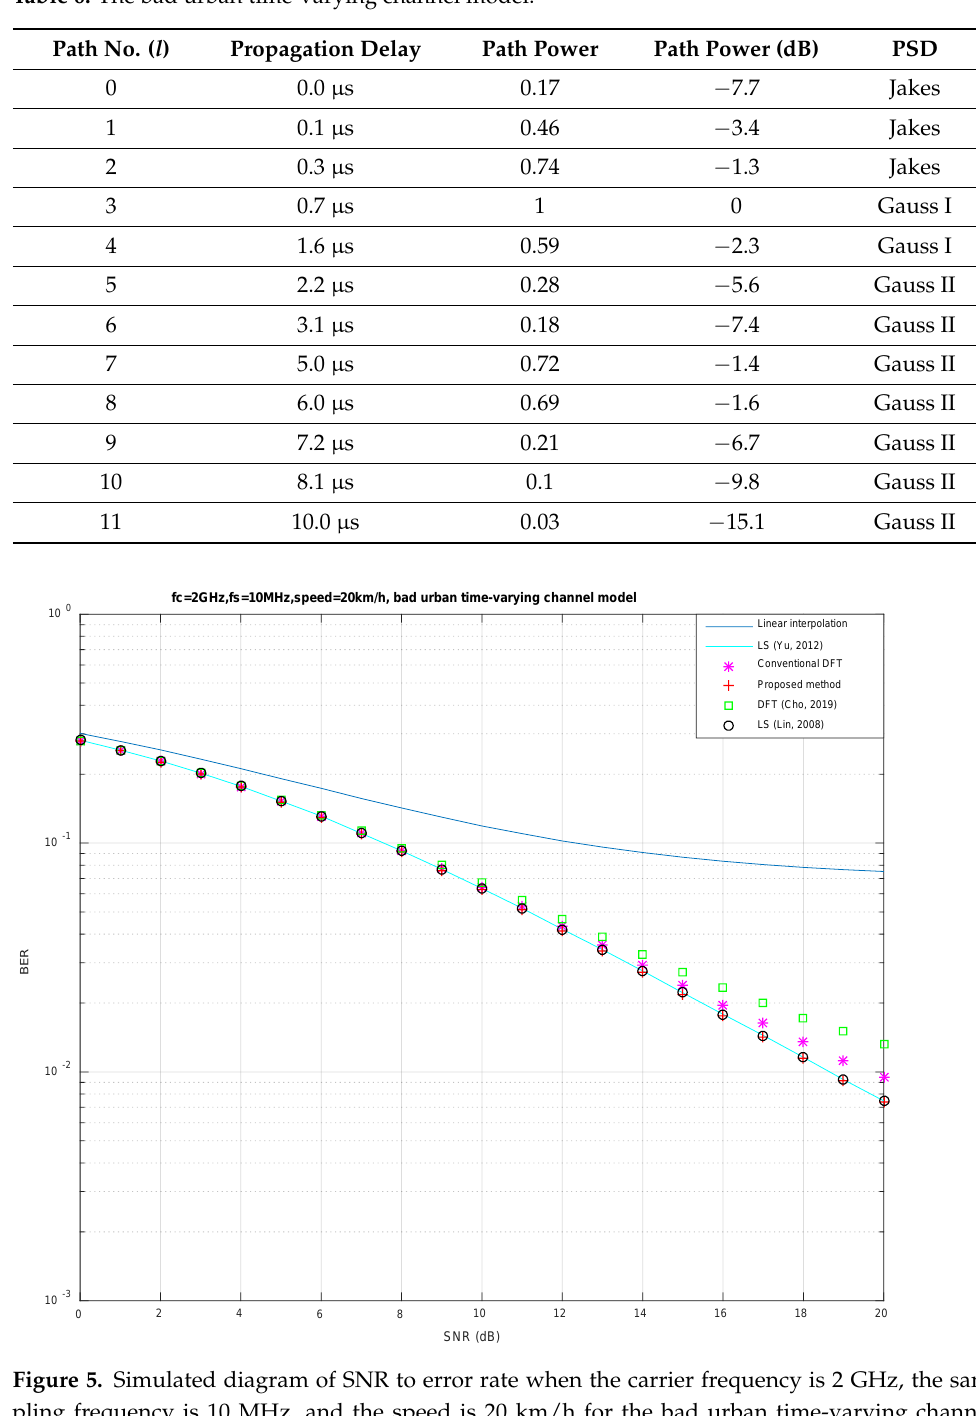
Table 6. The bad urban time-varying channel model.